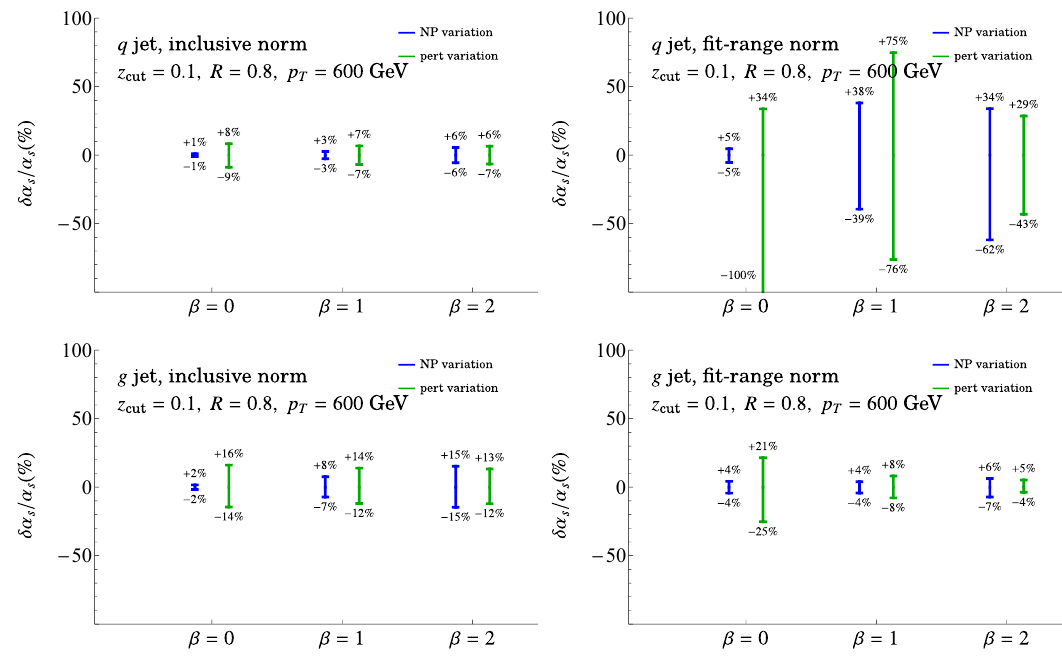
Figure 13 . Uncertainty in α s ( m Z ) due to profile variations and nonperturbative-parameter uncer- tainty, for different values of β , for the normalized soft-drop jet-mass cross